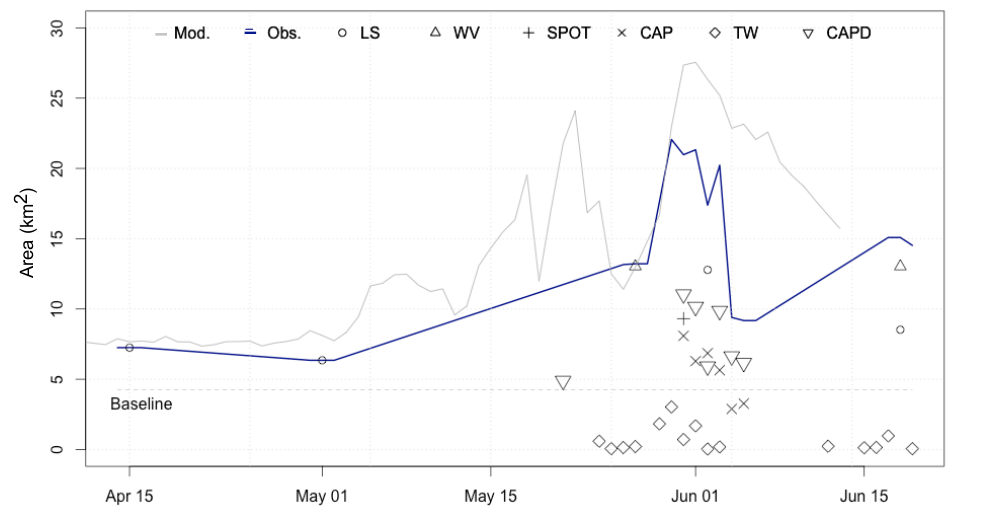
Figure 6. Data trends of the total area estimated from the remotely sensed product and simulated inundation over an eight-week time period. The total area of observed water is shown with a blue line and each dataset is represented by a series of symbols. The simulated water is represented by a gray line and the normal water area is shown with a dashed